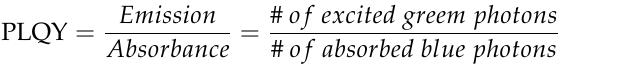
Figure 2f. EQE is defined as the ratio of the number of photons emitted into free space per second to the number of electrons injected into the LED per second, where P 0 is the